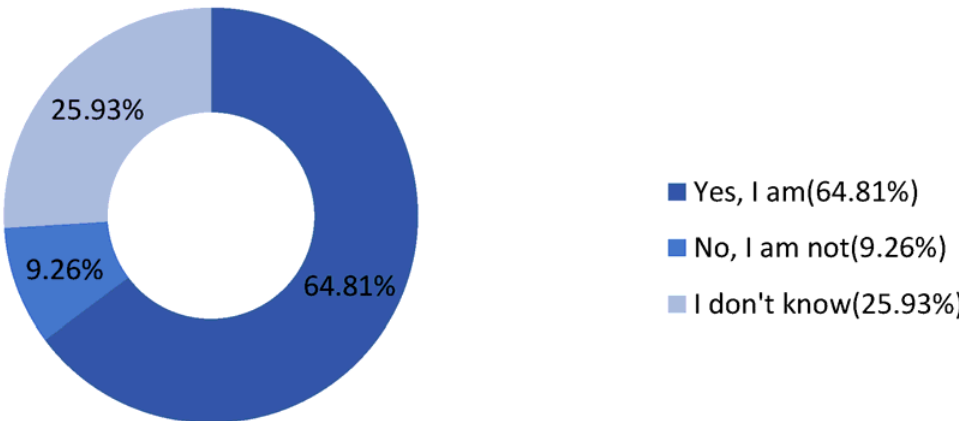
Figure 5. Villagers’ understanding of Lingquan Village planning. The original question was “Are you willing to participate in or assist in the traditional village protection activities of Lingquan Village?”.